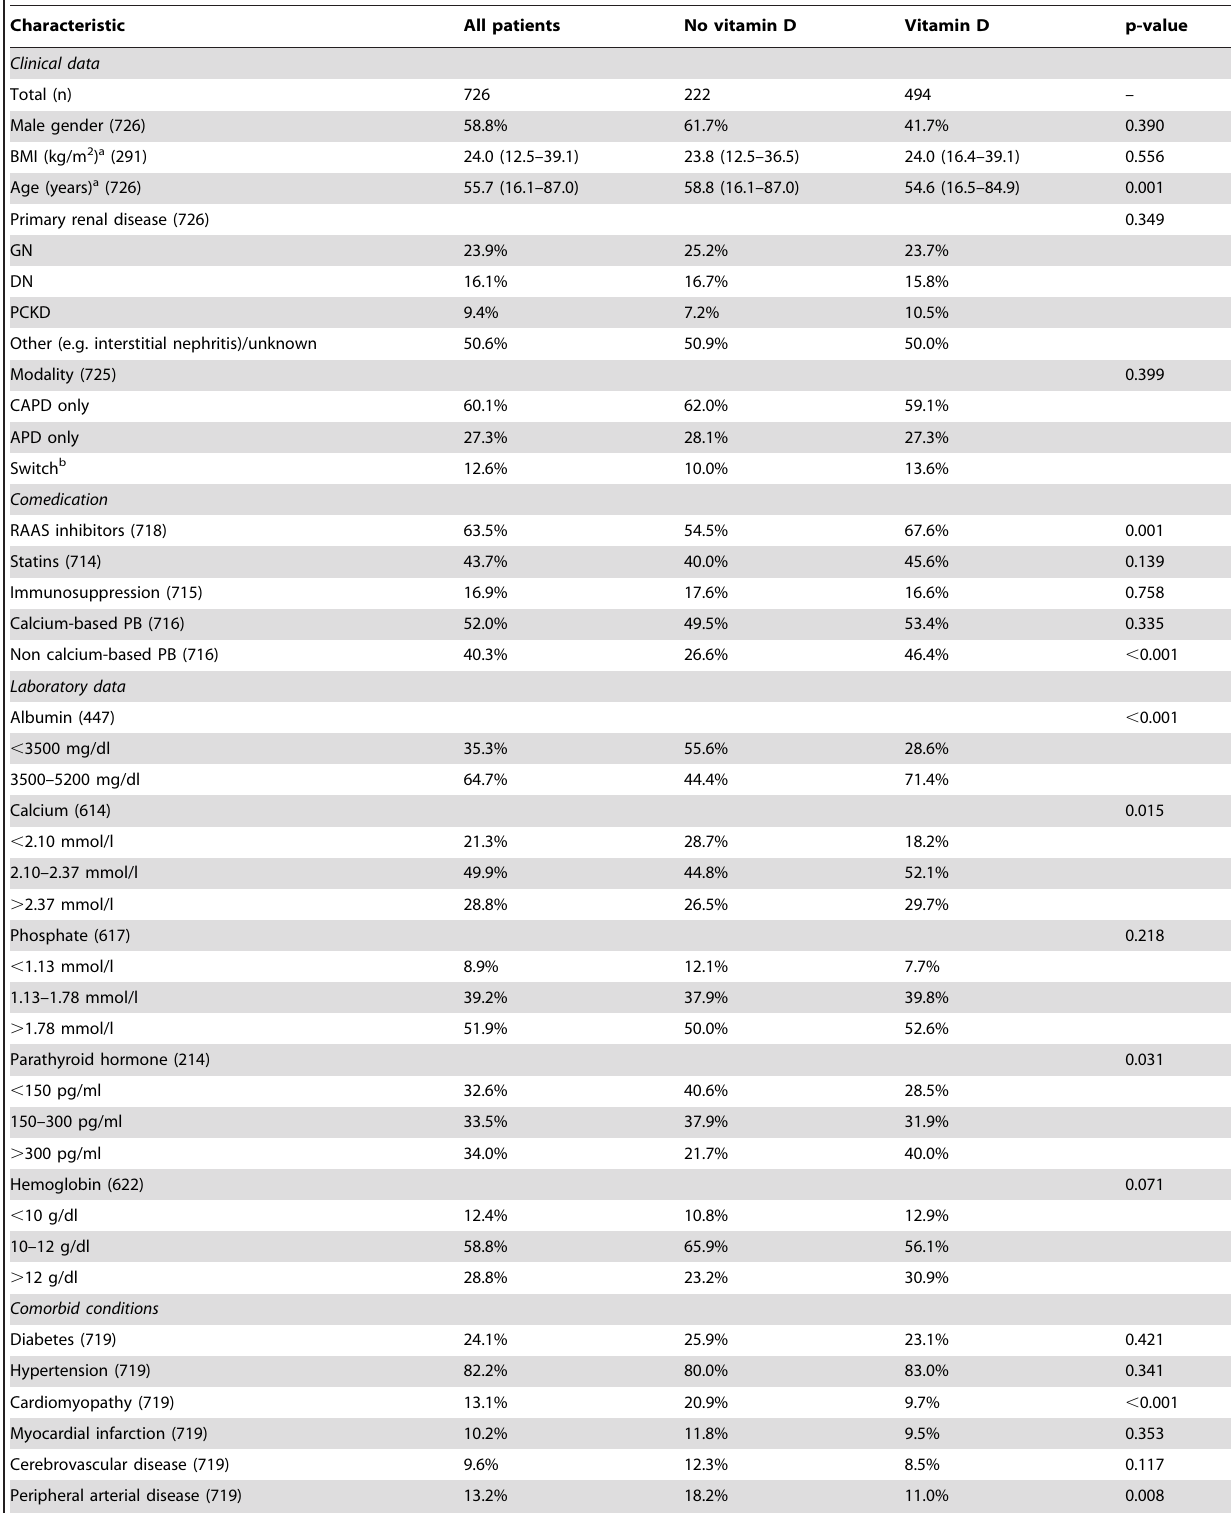
Table 6. Patient characteristics stratified by treatment with active vitamin